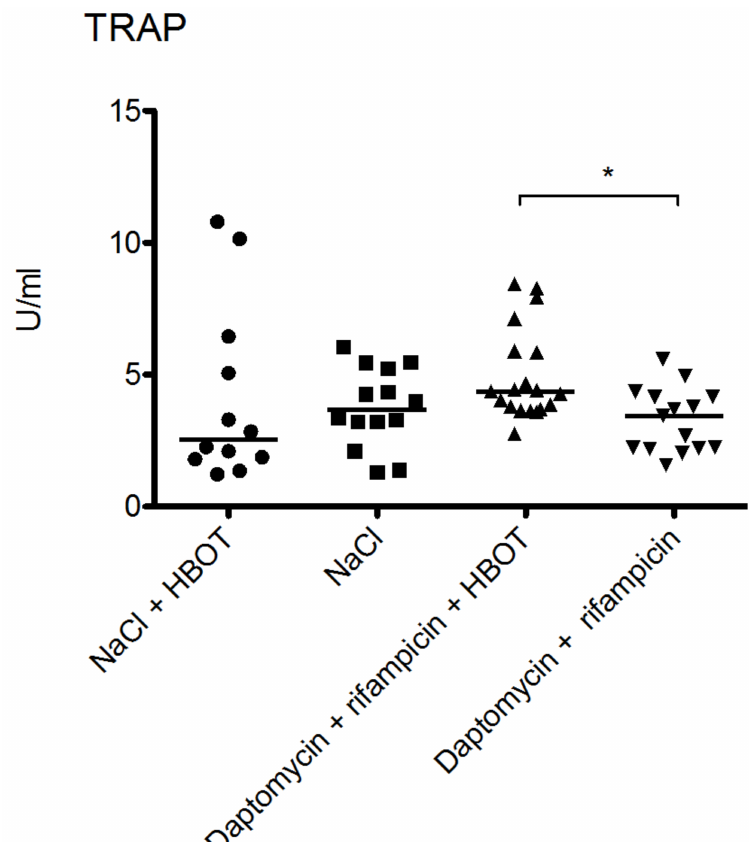
Figure 4. The tartrate-resistant acid phosphatase 5b (TRAP 5b) levels were comparable in both groups treated with NaCl. The median value for NaCl + HBOT was 2.549 U/mL (range: 1.230–10.79 U/mL), while median value for the NaCl group was 3.289 U/mL (range: 1.296–6.041 g/mL). Hyperbaric oxygen therapy resulted in a slight elevation of TRAP 5b levels in animals treated with daptomycin + rifampicin. The median TRAP 5b value was 2.770 U/mL (range 4.363–8.441 U/mL) in the daptomycin + rifampicin + HBOT group, which was higher than the median value in the daptomycin + rifampicin group of 1.577 U/mL (range 3.446–5.589 U/mL). * marks significan statistical difference ( p = 0.005, Mann–Whitney’s